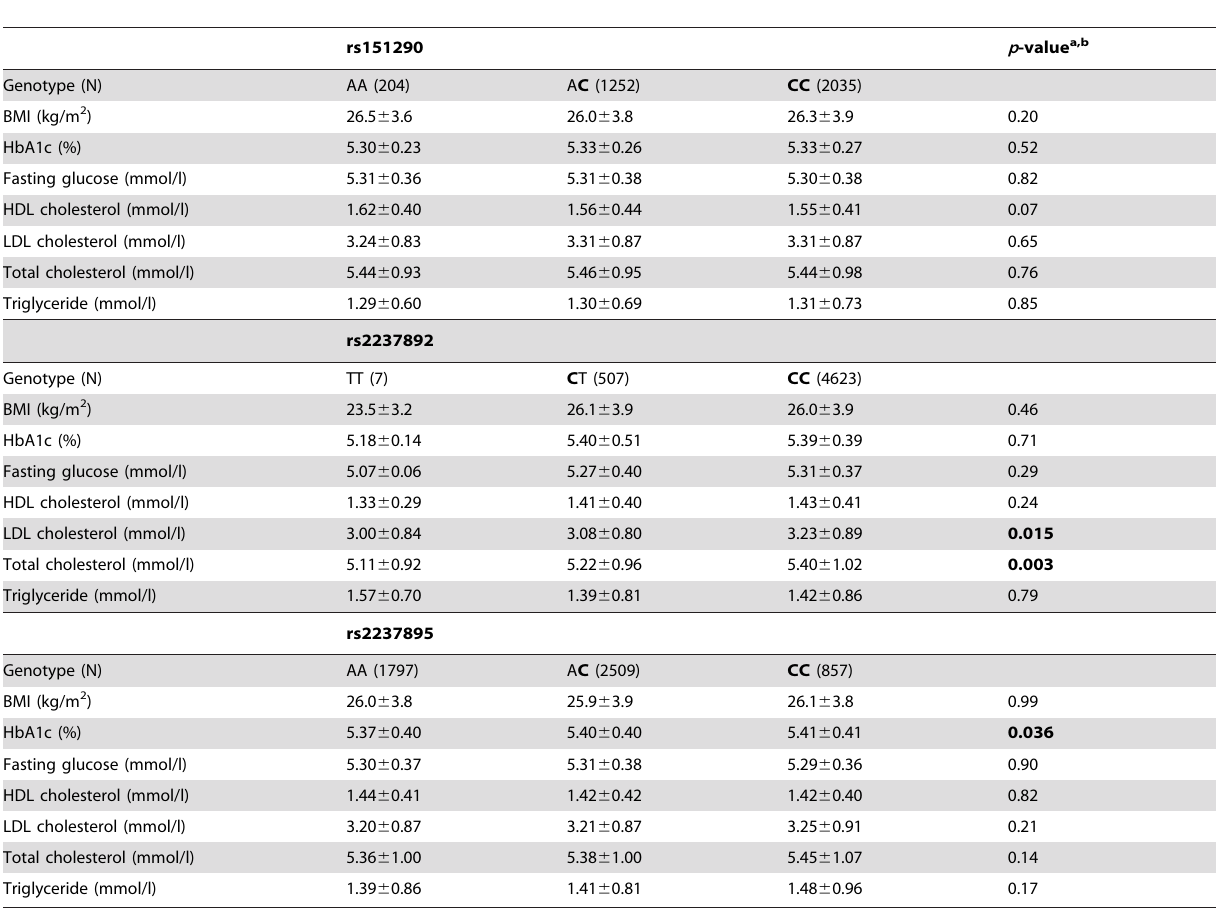
Table 4. Effect of KCNQ1 variants rs151290, rs2237892 and rs2237895 on quantitative metabolic traits in non-diabetic